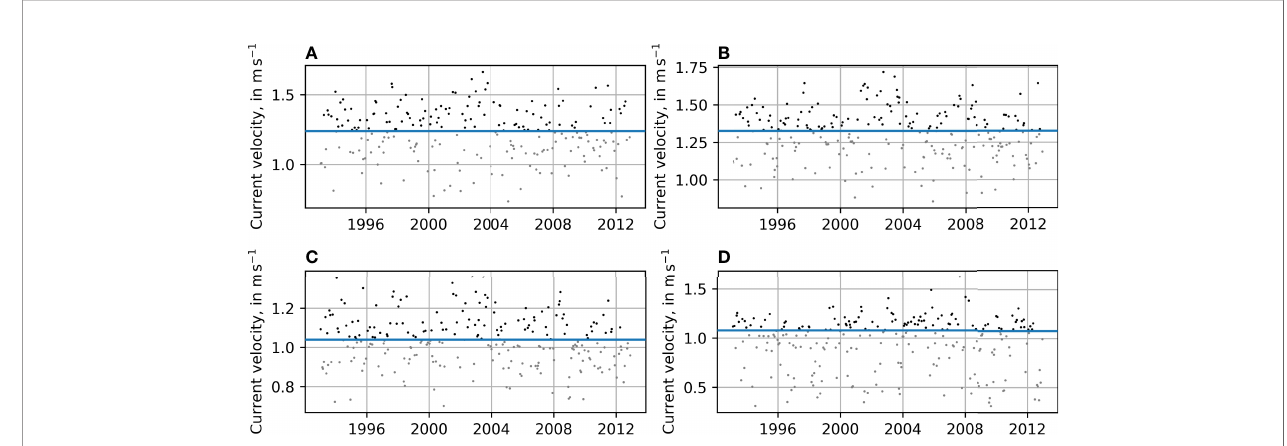
FIGURE 8 | Distribution of peaks over time for the nodes at P1 to P4, as identi fi ed by means of a 23 days moving time window. The peaks under threshold are marked with grey dots, the peaks over threshold with black dots, and the selected threshold by the blue line. (A) Node at P1, (B) Node at P2, (C) Node at P3, and (D) Node at P4.